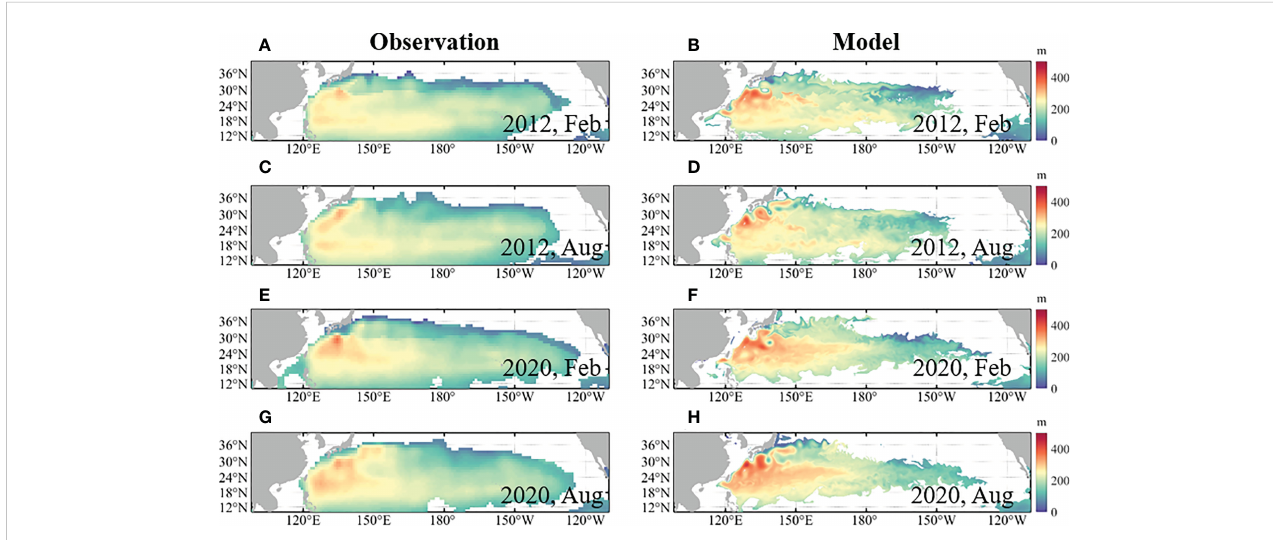
FIGURE 3 Comparison of the mid-depth of STMW between (A, C, E, G) EN4 and (B, D, F, H) model results in (A, B) February 2012, (C, D) August 2012, (E, F)